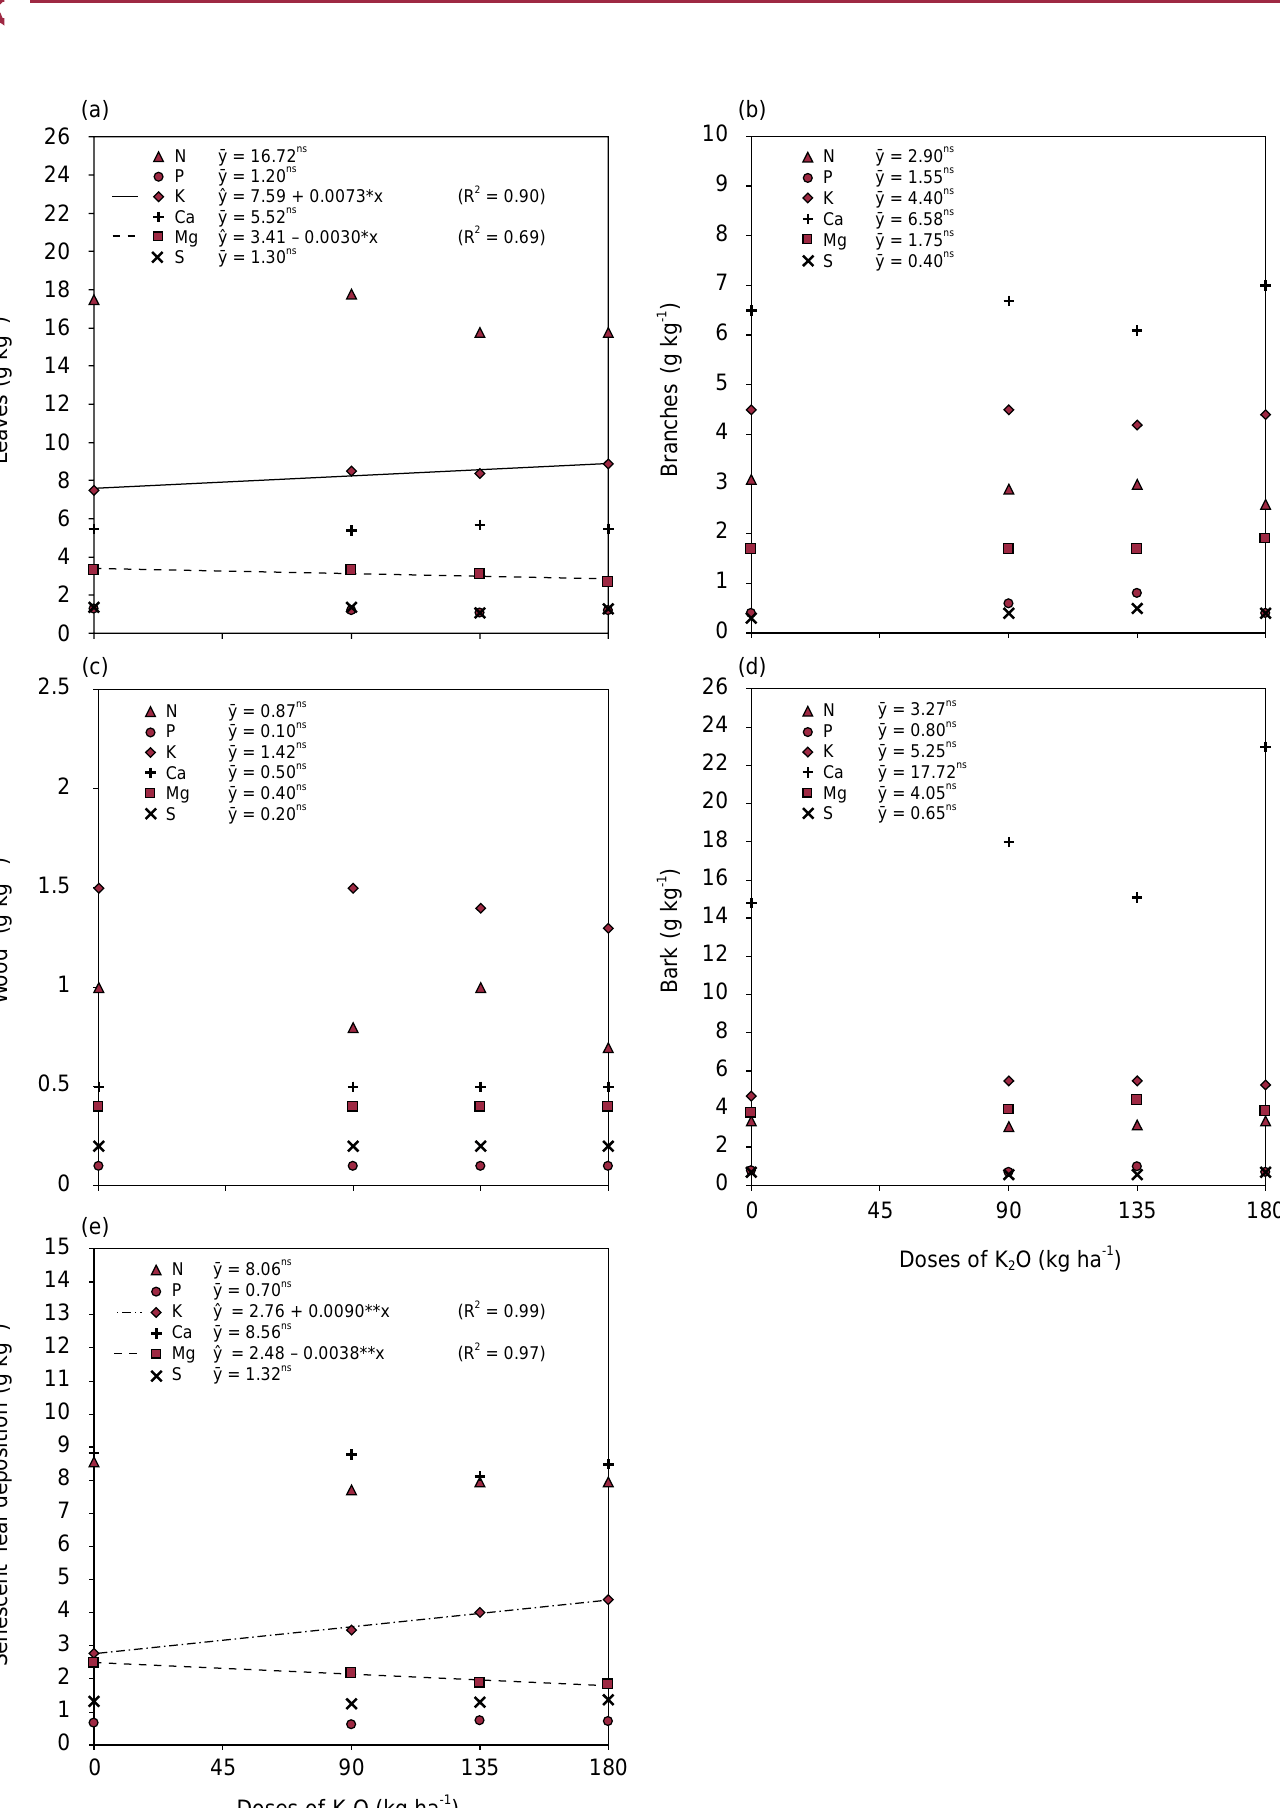
Figure 3. Contents of nitrogen, phosphorus, potassium, calcium, magnesium, and sulfur in the different compartments of Eucalyptus plants (leaves, branches, wood, and bark, respectively, a, b, c, and d) and senescent leaf deposition mean (e), as a function of doses of K 2